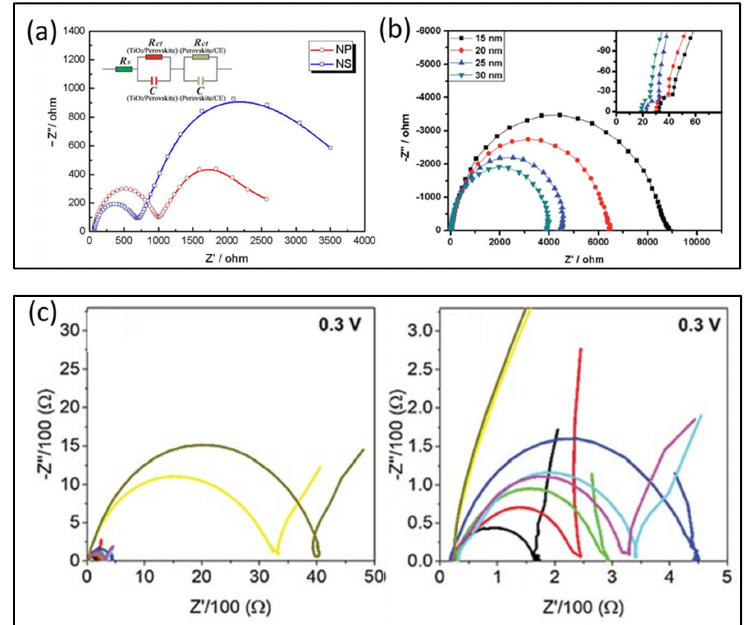
Figure 8. Nyquist plots of carbon-based monolithic HTM-free PSCs: ( a ) with TiO 2 nanosheets and TiO 2 nanoparticles, measured at 0.6 V in the dark (Reproduced with permission from [40], American Chemical Society, 2014.); ( b ) with a di ff erent thickness of TiO 2 mesoporous layers, measured at 0.7 V in the dark (Reproduced with permission from [42]. Royal Society of Chemistry, 2015.); and ( c ) with di ff erent spacer layer thickness (0 µ m (black), 0.08 µ m (red), 0.11 µ m (green), 0.66 µ m (purple), 2.64 µ m (light blue), 3.31 µ m (dark blue), 4.84 µ m (yellow), and 5.96 µ m (black with yellow shade), measured at 0.3 V under 0.1 sun illumination (Reproduced with permission from [70]. Royal Society of Chemistry,